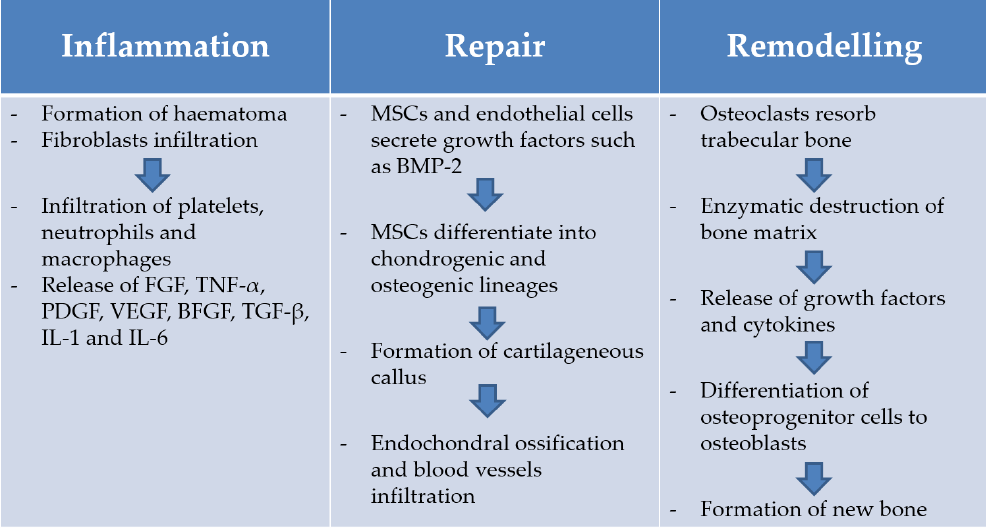
Figure 1. Bone healing process. BMP-2: bone morphogenetic protein-2.